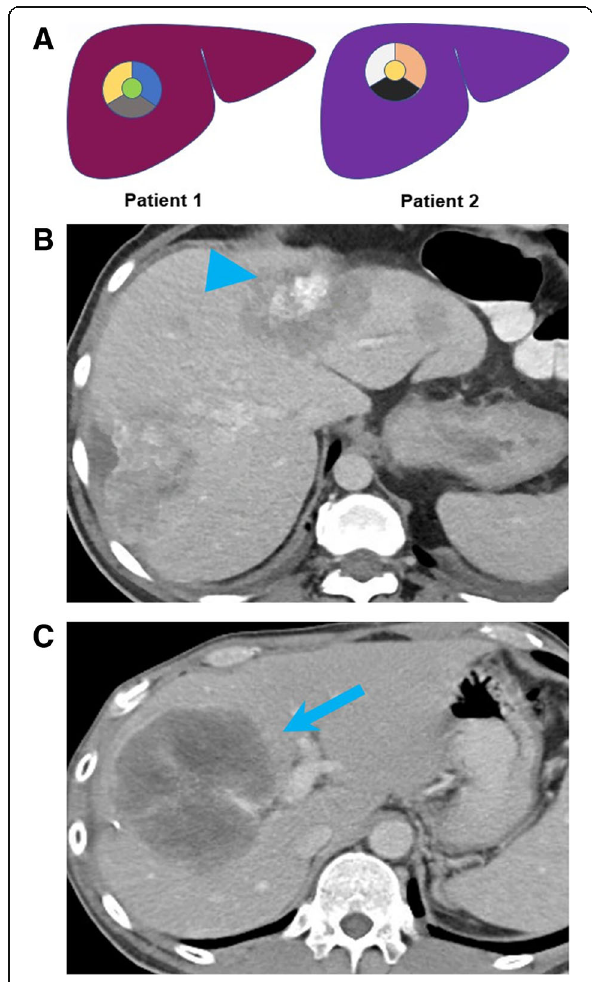
Fig. 10 Interpatient heterogeneity. a Image showing mutational heterogeneity among tumors of different patients, where different mutations are depicted in different colors. b , c Axial CT images acquired during portal venous phase in two different patients with pathological diagnosis of metastatic adenocarcinoma of the colon. One patient shows partially calcified metastases (arrowhead) ( b ); one patient shows hypodense heterogeneously